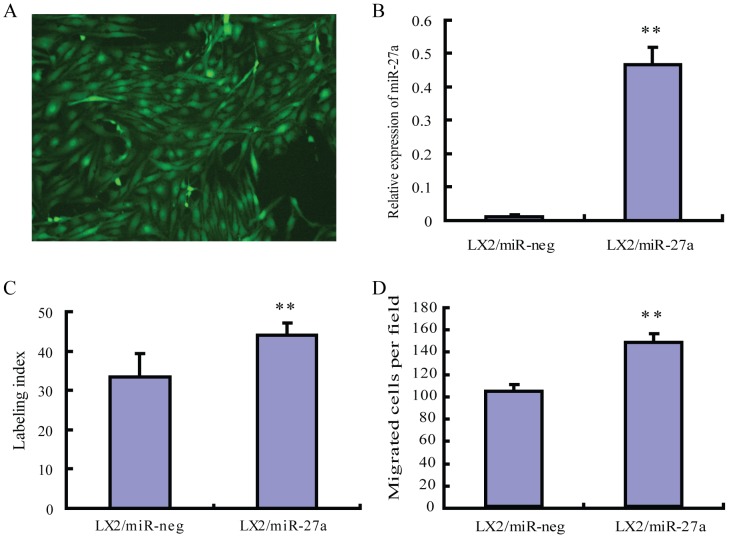
Establishment and biological characters of LX2/miR-27a, LX2/miR-neg stable transfectants.(A) Almost all cells in the positive clone expressed EmGFP (green), original magnification ×200. (B) The expression of miR-27a in LX2/miR-27a, LX2/miR-neg stable transfectants. (C) Over-expression of miR-27a promoted LX2 cell proliferation. (D) miR-27a over-expression facilitated LX2 migration. **P<0.01 compared with LX2/miR-neg.